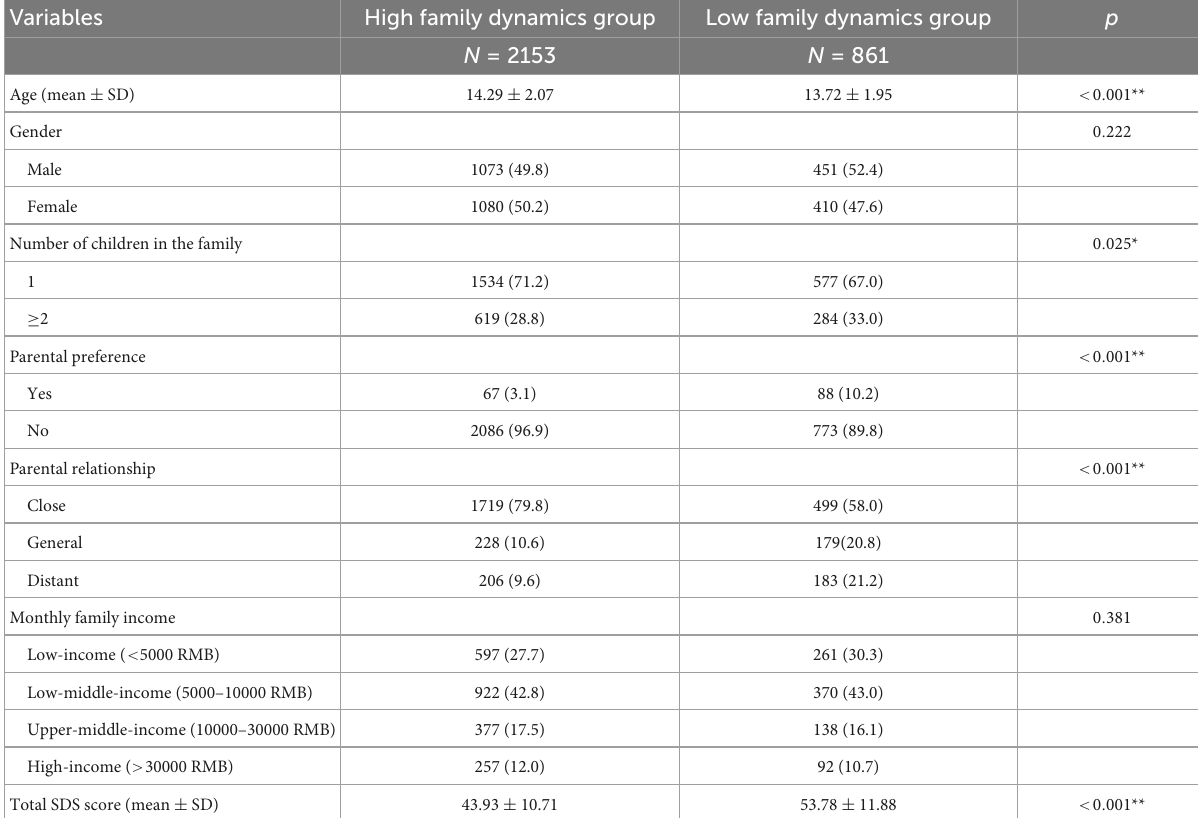
TABLE 5 Comparison of demographic characteristics and total SDS scores among two latent